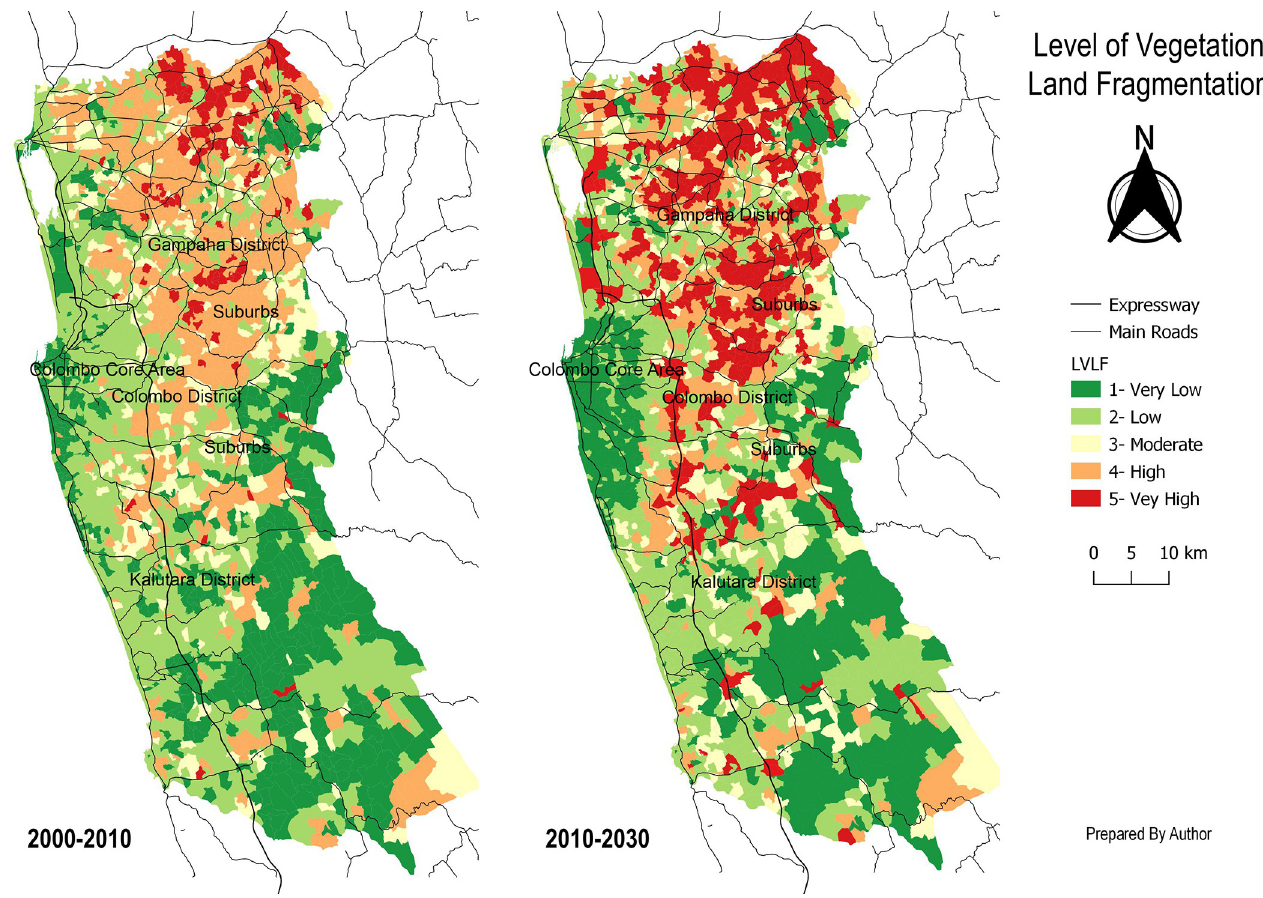
Fig 14. Map of Future LVLF in Western Province, Sri